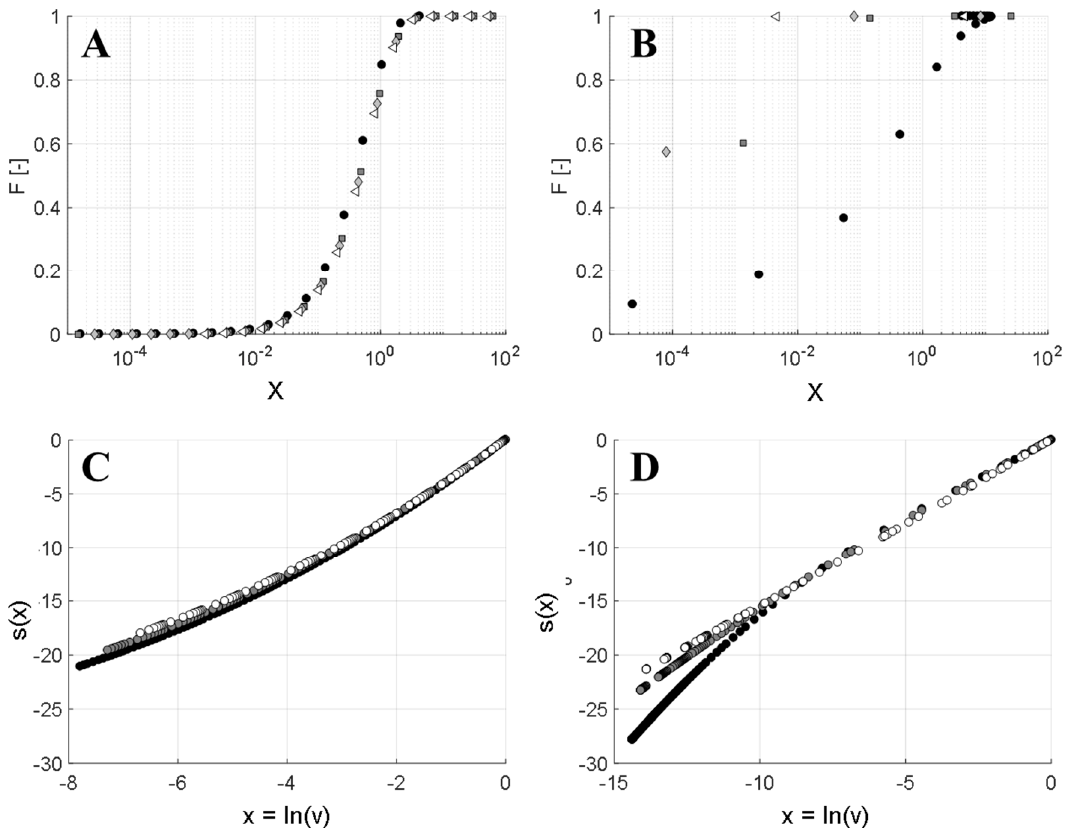
Figure 7. Self-similar fragmentation. The upper row ( A , B ) shows a series of cumulative drop size distributions (DSDs) as a function of the similarity variable, X (see Equation (19)), showing how one of the cases ( A ) is self-similar (collapses) and the other ( B ) is not. The second row ( C , D ) shows the arc-length, s ( x ), plots often used for investigating self-similarity. ( A , C ) g* = v 2 , f* ( v | v’ ) = 2 / v’ . ( B , D ) g* according to Coulalogou and Tavlarides [41] and f* as in ( A ).